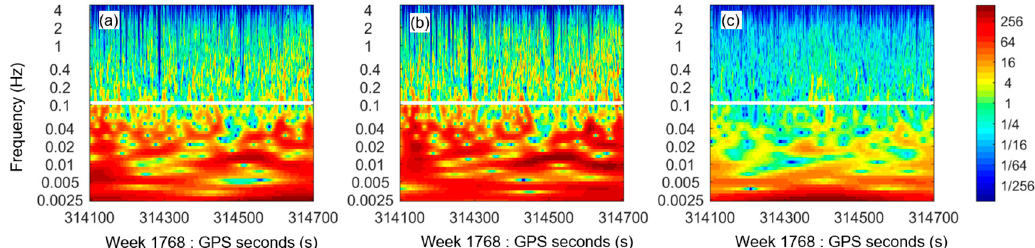
Figure 5. The continuous Morlet wavelet transform (CMWT)-based spectra of the measurement noise of the composite instrument in the x -axis ( a ), y -axis ( b ) and z -axis ( c ), corresponding to displacement time series in Figure 4 with white lines indicating the frequency of 0.1 Hz. The horizontal axis indicates the GPS time, which is composed of GPS weeks and week seconds. The color pattern indicates the amplitudes of the energy spectrum that are dimensionless.